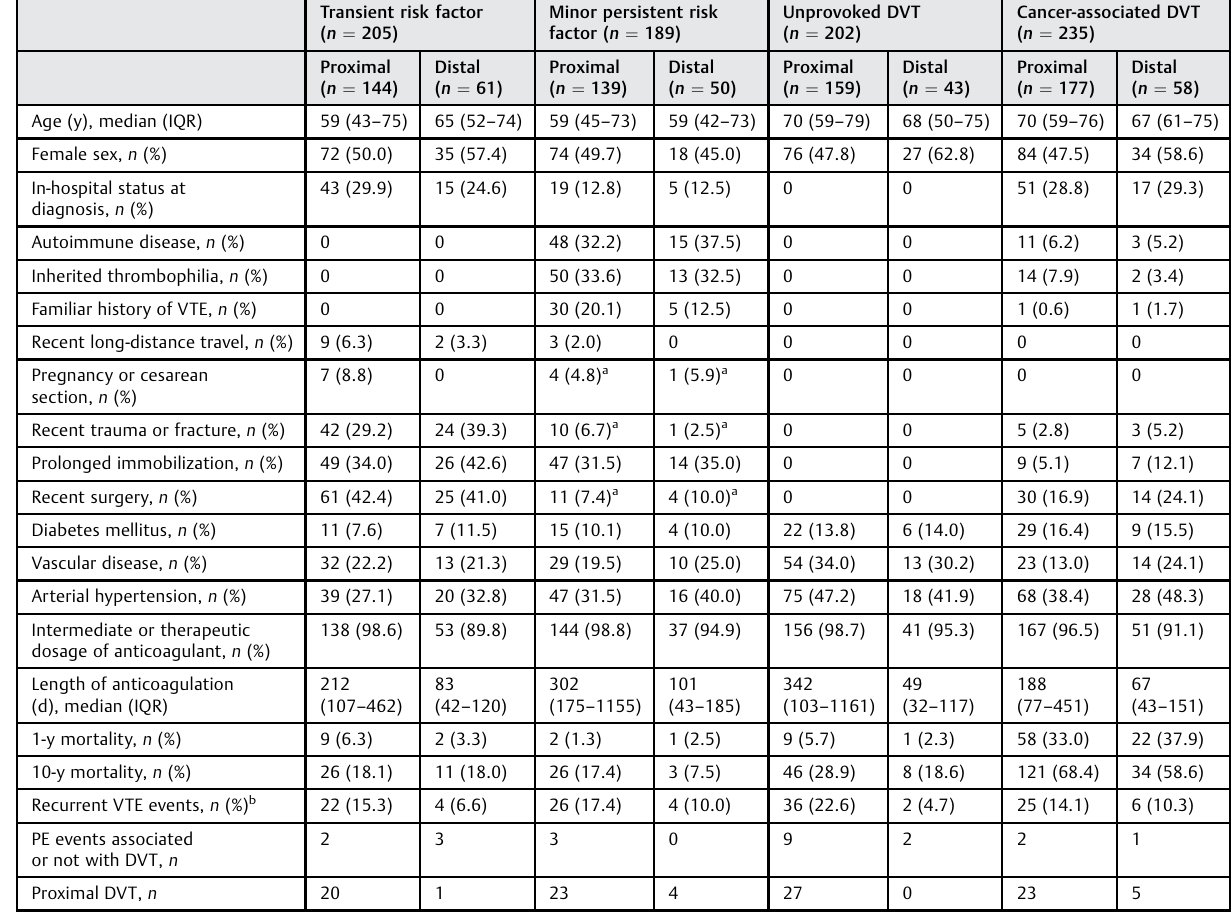
Table 1 Baseline characteristics of the study population, number of recurrent events, and mortality